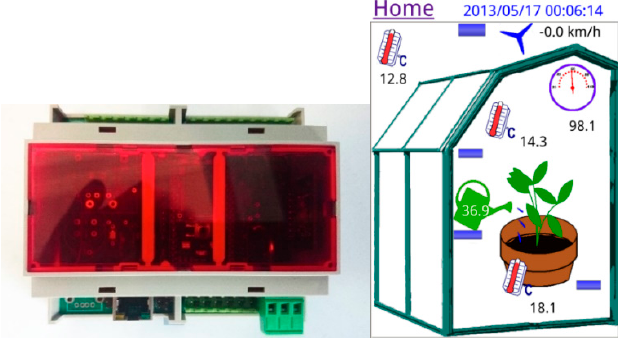
Figure 16. Ethernet gateway module and the web page for remote monitoring and control, provided by its embedded web server as seen on smartphone.